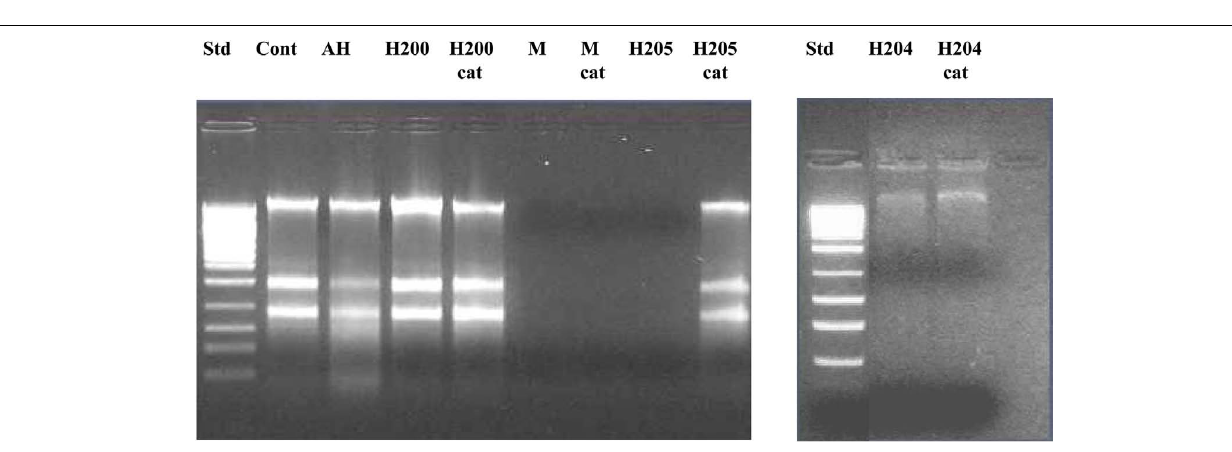
untreated E. coli cells, AH-cell treated with artificial honey, or buckwheat honeys H200, H205, and M-manuka honey after 24h incubation and H204 after 8h